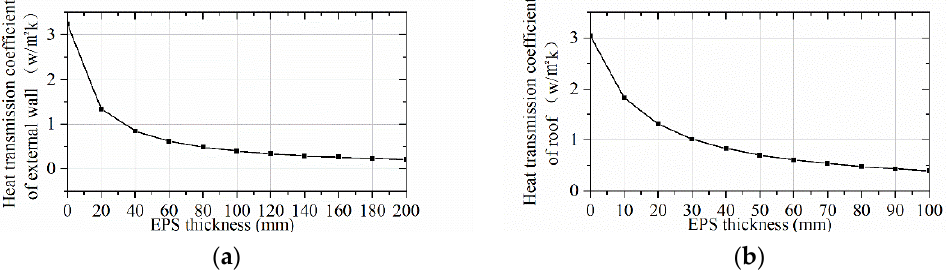
Figure 8. ( a ) The relationship between the heat transfer coefficient and the thickness of external wall insulation material; ( b ) the relationship between the heat transfer coefficient and the thickness of roof insulation material.